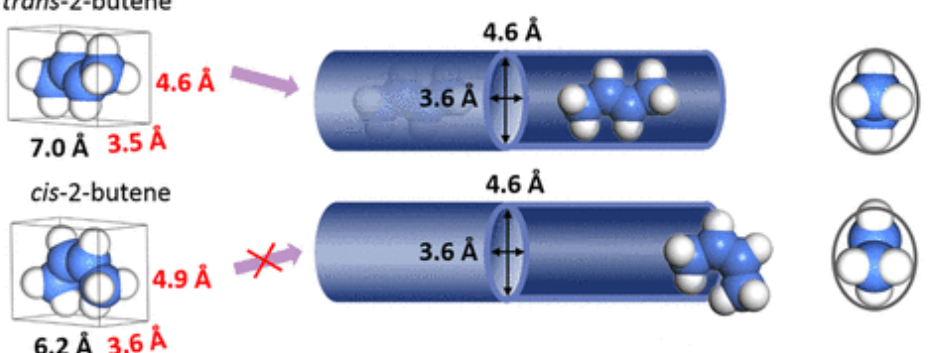
Figure 4. Schematic diagram of shape-selective separation of trans -2-butene and cis -2-butene. Reprinted with permission [83].